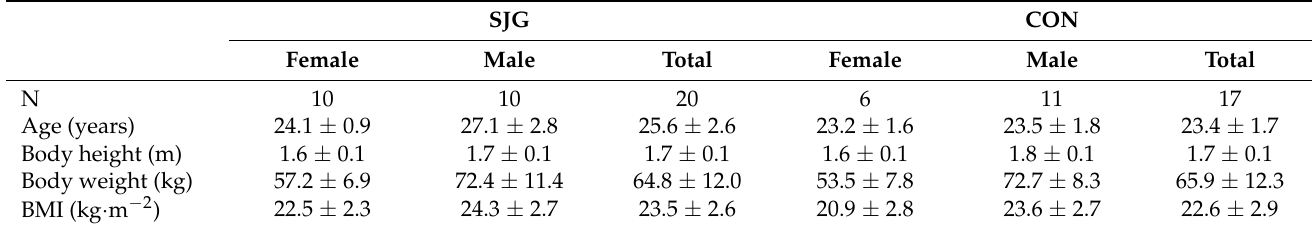
Table 1. Means and standard deviations of the subjects’